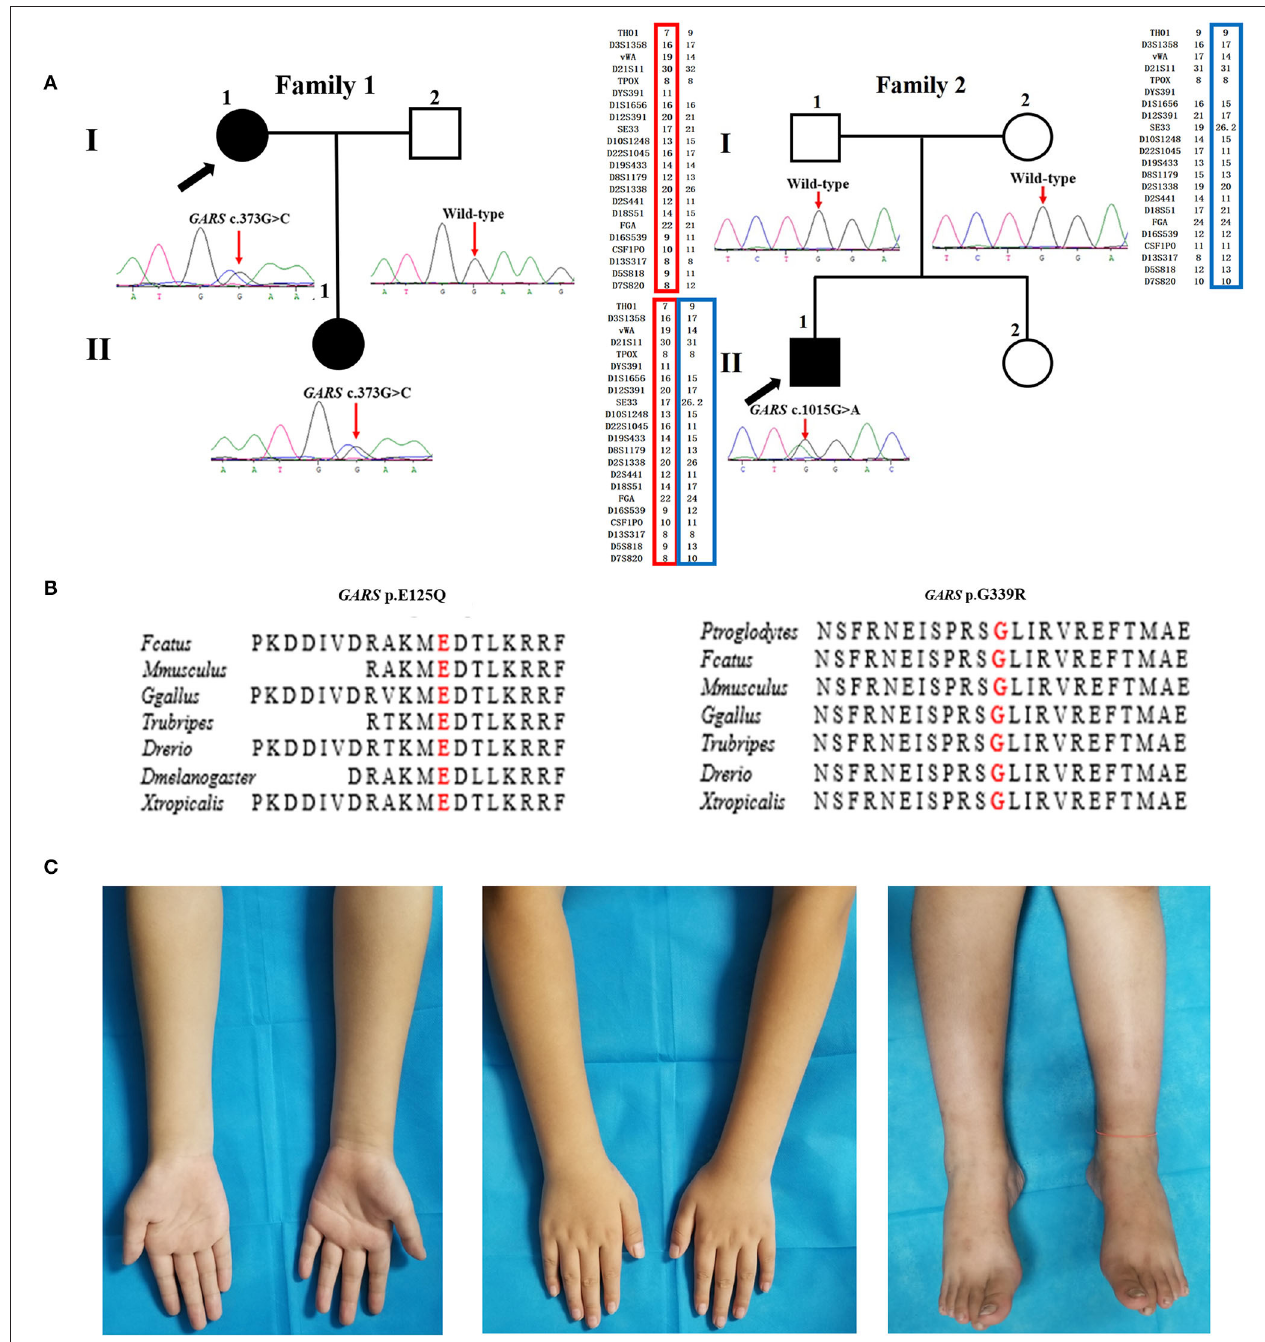
FIGURE 1 | Pedigree, sequencing electropherograms, conservation analysis, and clinical imaging features of distal hereditary motor neuropathy (dHMN) families with GARS mutation. (A) Pedigrees of family1 ( GARS c. 373G > C) and family 2 ( GARS c.1015G > A), and chromatograms of the mutation sites confirmed by Sanger sequencing. The GARS c.1015G > A variant is shown to be a de novo variant by comparing 22 core STR markers. Square, male; Circle, female; Black filled symbol, clinically and electromyogram confirmed affected individual; Empty symbol, clinically healthy individual; M, mutant type; W, wild-type; Arrows, probands. (B) Conservation of the residues surrounding Glu acid (E) 125 (red) and Gly (G) 339 in GARS among species. (C) Images of the upper and lower limbs of the proband in family 2(II-1).